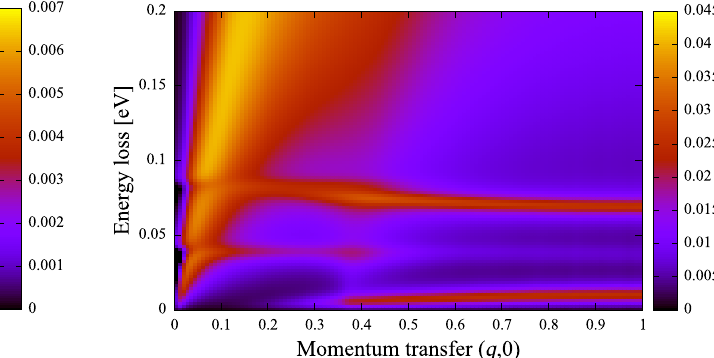
FIG. 10. Sum of all contributions. Momentum transfer is given in units of π =a